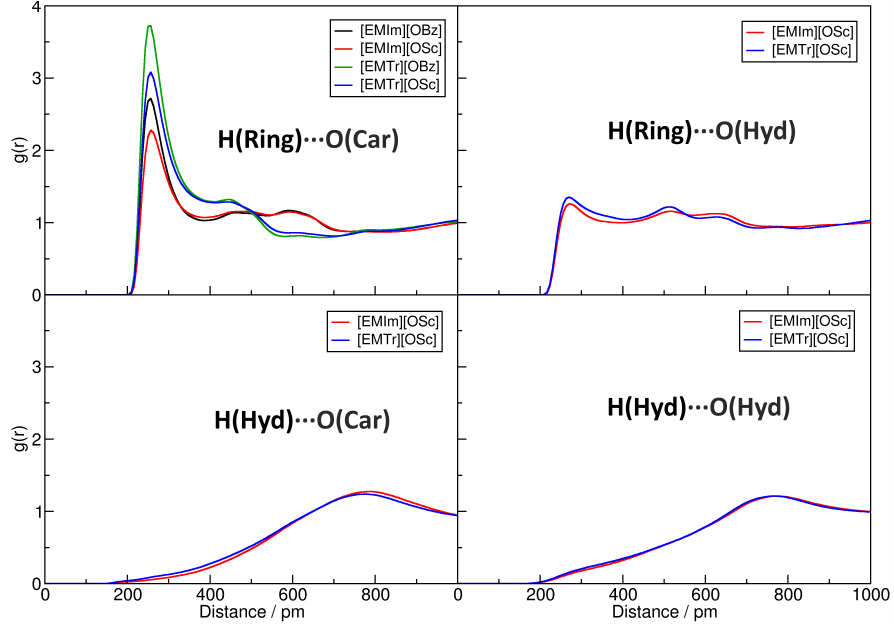
Figure 3. Computed radial distribution functions (RDFs) for the four pure ILs from the MD simulations. Peaks at 200. . . 300pmwith a height > 1 indicate hydrogen bonds. For the abbreviations, see Figure